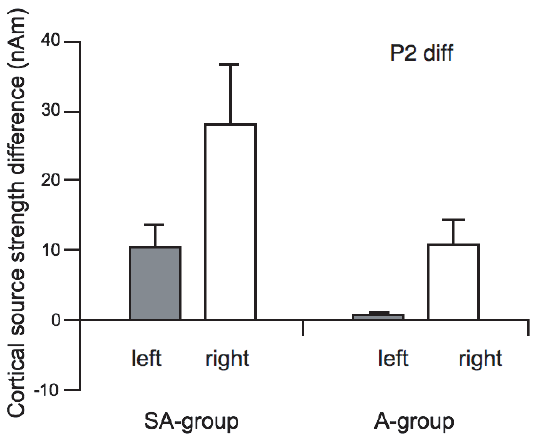
Figure 4. Group averages of the pretraining/posttraining differences of the individual P2 source waveform peak amplitudes from both groups and hemispheres. Left: left hemisphere; right: right hemisphere; seq: sequence. Error bars indicate SEM.